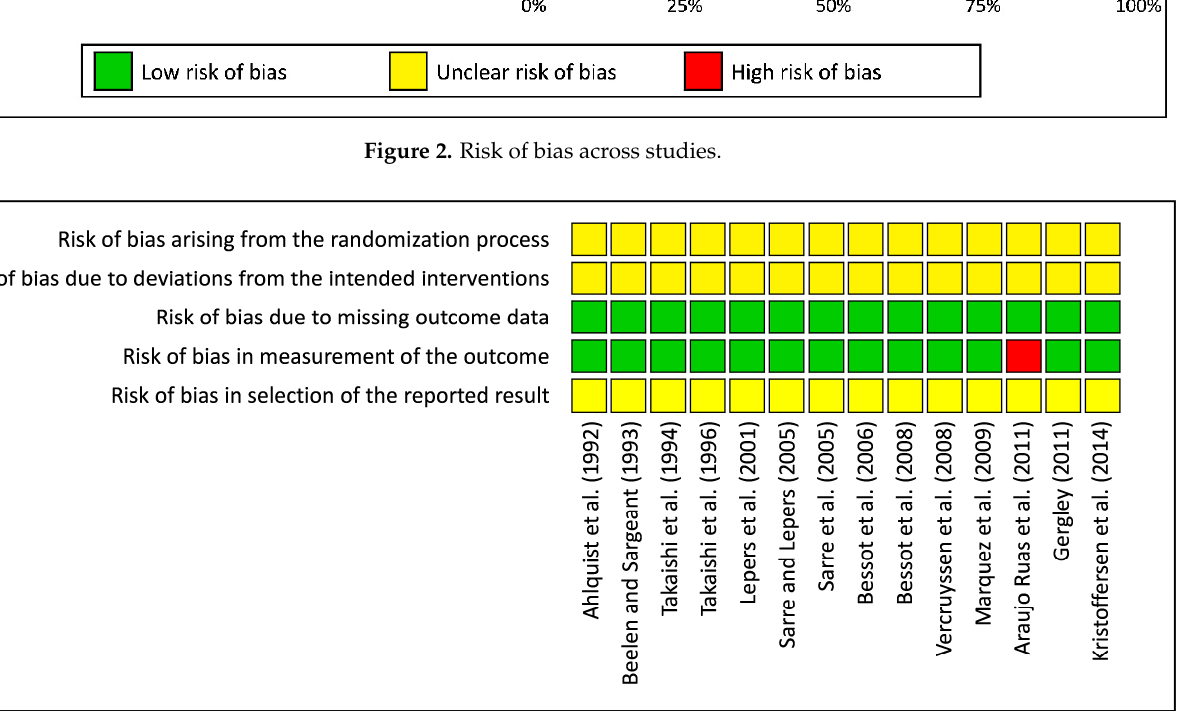
Figure 3. Risk of bias within studies .